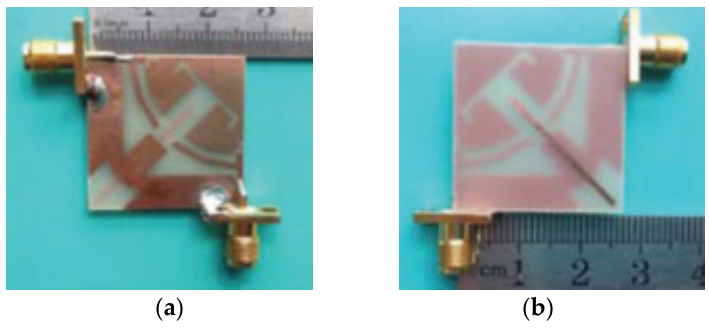
Figure 8. ( a ) Top layer of ACS-fed structure with common radiator ( b ) Bottom layer [66].